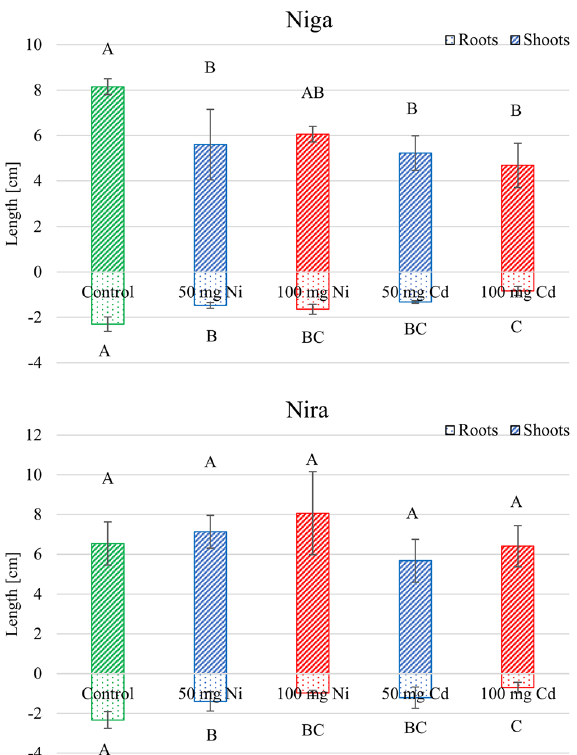
Figure 6. Length of shoots and roots of two perennial ryegrass turf cultivars (‘Niga’ and ‘Nira’) under different Ni and Cd treatment (0; 50 and 100 mg × 100 g −1 of substrate). Means within one cultivar marked by different letters represent significant differences ( p < 0.05, n =